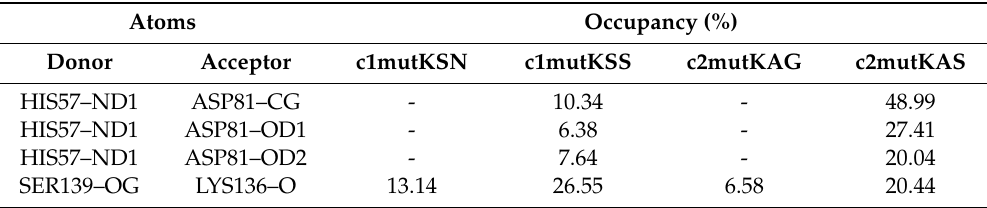
Table 2. H-bond pairs and their occupancy in the HCV-1a clade systems.